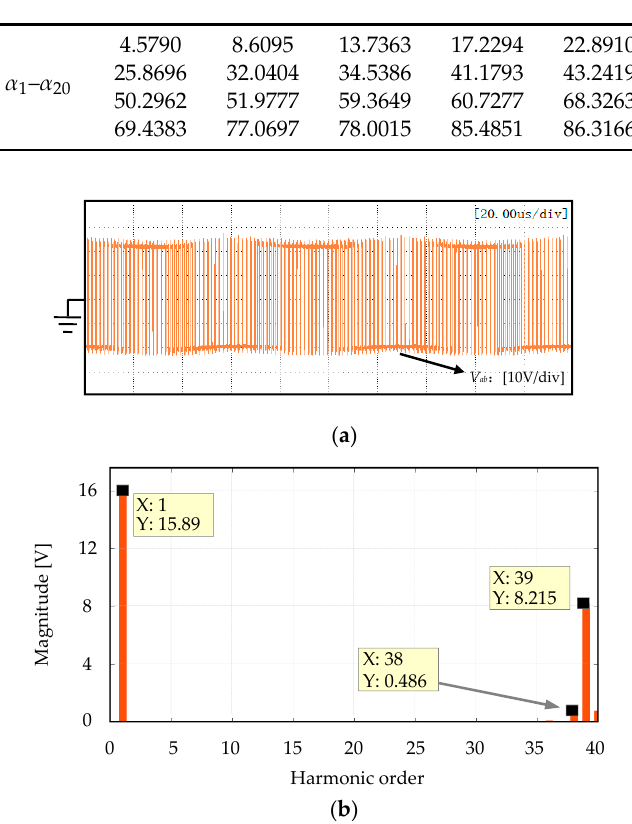
Figure 11. Experimental waveforms at V ac 1 = 0.8, V ac 2 = 0.4 (normalized), V dc = 20 V and k = 39. ( a ) Full bridge voltage V ab and ( b ) its spectrums.